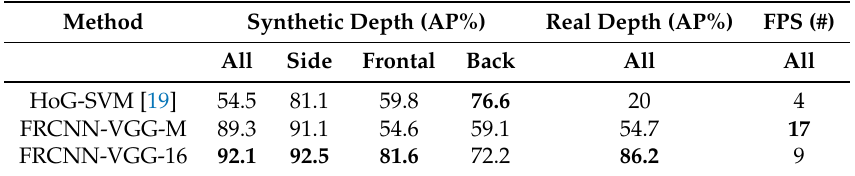
Table 1. Performance of the different methods on both the synthetic and real depth testing datasets according to the average precision (AP) (%) evaluation metric and the number of frame per second (FPS). The synthetic depth testing datasets were divided into four subsets for evaluation based on the kangaroo orientation from the perspective of the range